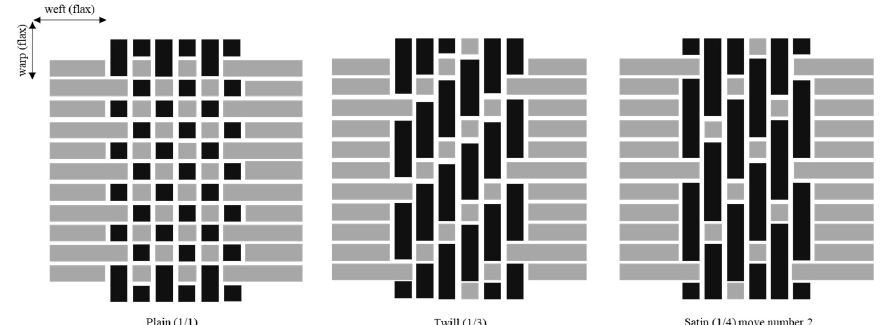
Figure 2. Schematic representation of the basic weave patterns: plain (1/1) meaning one warp yarn down and one warp yarn up, twill (1/3) meaning one warp yarn down and three warp yarns up and the satin (1/4) move number 2 meaning one warp yarn down and four warp yarns up with the displacement to the new line by step two.